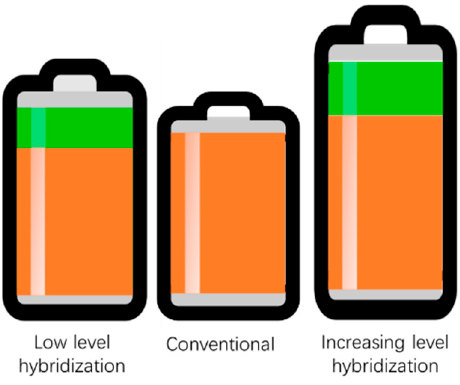
Figure 2. Classic hybridisation results in different degrees of hybridisation.